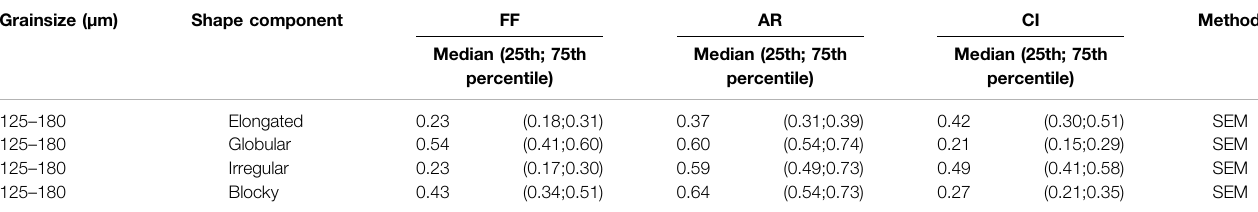
TABLE3| Main2DMorphologicalparametersoftheshapecomponentsinthe125 – 180 µmfractionoftheEtna21Maytephrafalldeposit,averagedoverlocationsI,IIandIII (SEM measurements). Grainsize